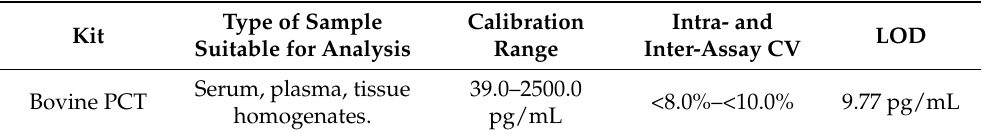
Calibration Intra- and LOD Range Inter-Assay CV